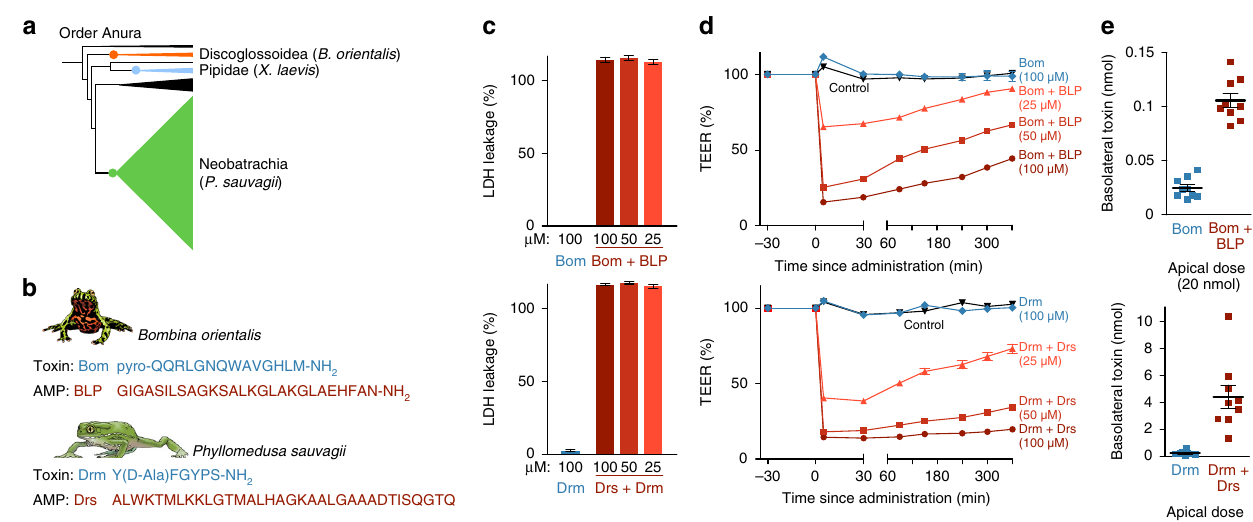
Fig. 3 The role of frog AMPs in toxin absorption in other frog species. a Representatives of three major frog lineages cosecrete peptide toxins and AMPs. b Amino-acid sequences of the Bombina ortienalis toxin bombesin (Bom) and AMP bombinin-like peptide 1 (BLP), and of the Phyllomedusa sauvagii toxin dermorphin (Drm) and its AMP dermaseptin-S1 (Drs). c LDH leakage indicates cell damage in Caco-2 monolayers when exposed to the AMP+ toxin mixtures, but not to the toxins alone ( n = 6 – 7; 100% corresponds to the LDH leakage caused by complete cell lysis as induced by Triton-X). d BLP and Drs induce a dose-dependent rapid drop in transepithelial electrical resistance (TEER) of Caco-2 monolayers ( n = 9, one-way ANOVA, F DRS (4,40) = 1284, F BLP (4,40) = 2054.1, p < 0.0005). e Co-administration of BLP and Drs at the apical side of Caco-2 monolayers leads to higher toxin levels after 60 min at the basolateral side, showing enhanced transepithelial transport of bombesin ( n = 9, t -test, t (11.6) = − 11.2, p < 0.0005) and dermorphin ( n = 8 – 9, t -test, t (8.1) = − 4.8, p < 0.0005). All data are mean ± s.e.m., error bars not shown when covered by data